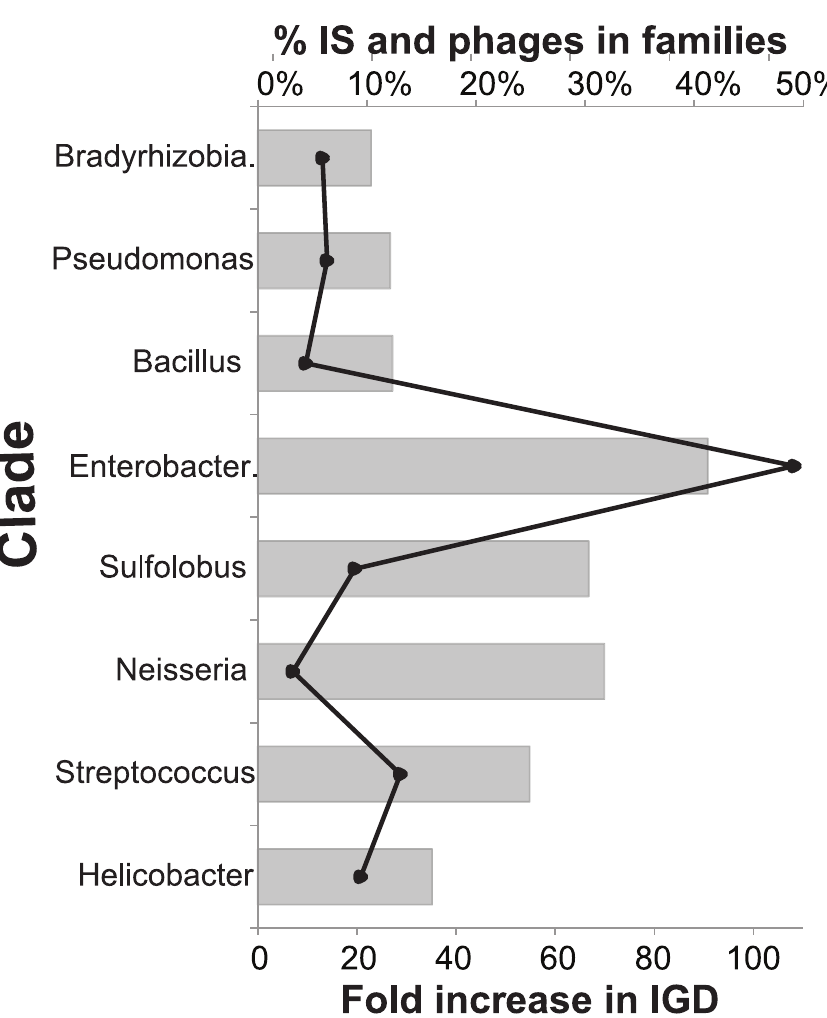
Figure 3. Abundance of IS and prophages and increased inference of IGD events when included in analysis. The bar plot (left y-axis) shows the percentage of gene family expansions of IS and phage origin. The line plot (right y-axis) indicates the increase of the number of expansions assigned to duplications when the co-localization criterion is ignored and IS and prophages are included in the dataset.